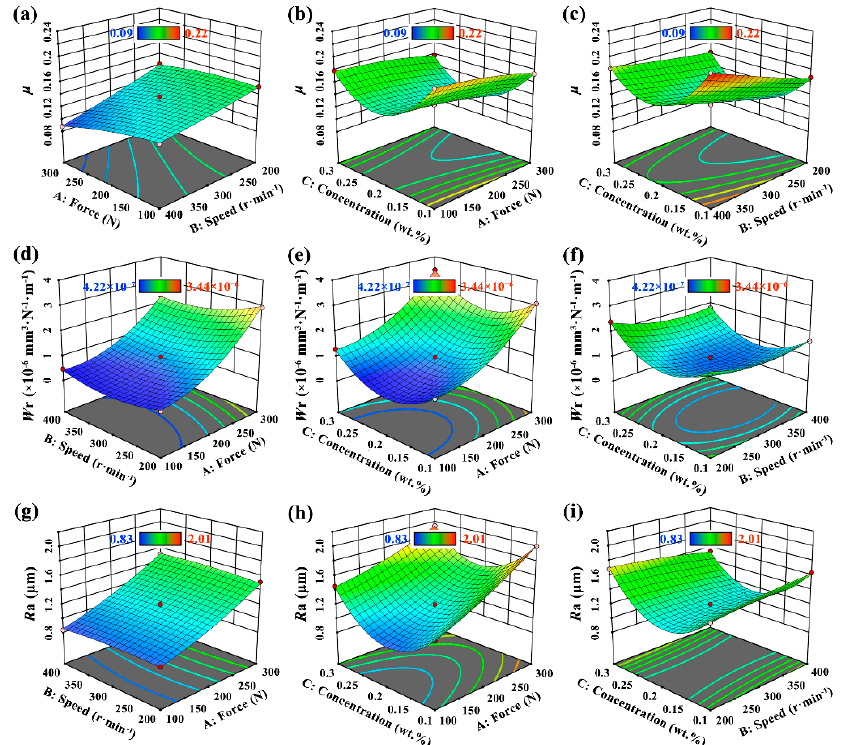
Figure 6. 3D response surface plots showing the interaction effects of different variables on ( a – c ) μ , ( d – f ) W r and ( g – i ) R a values. ( d – f ) W r and ( g – i ) R a